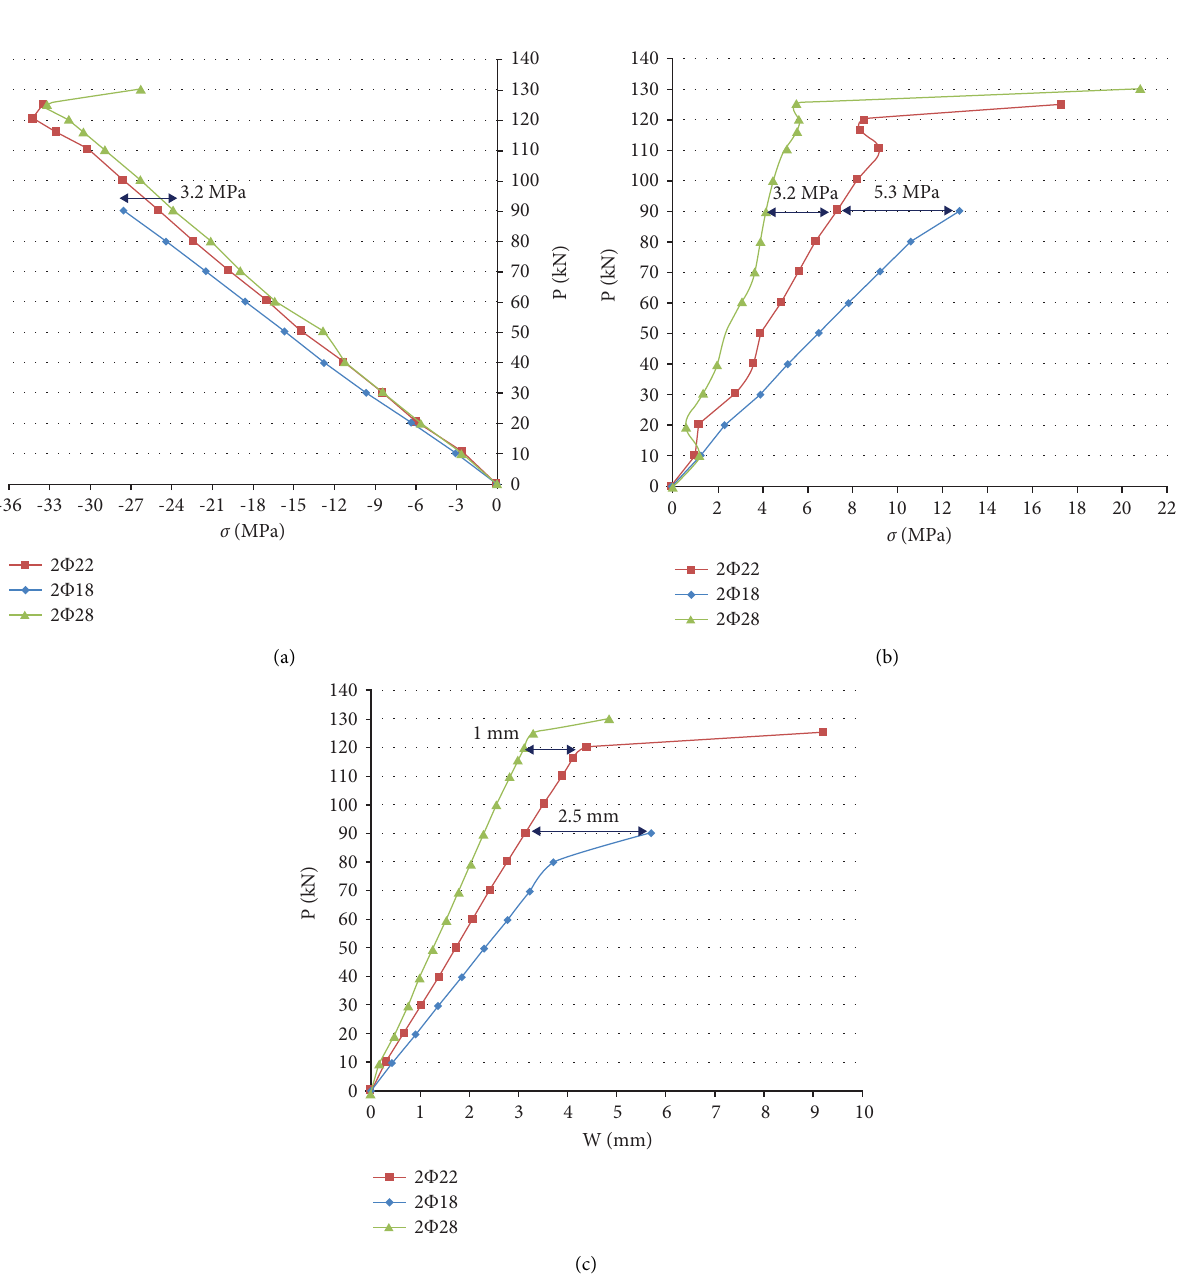
Figure 20: Relationship between load and stress, as well as between load and vertical displacement (efect of the diameter of tensile steel bars): (a) relationship between load and compressive stress, (b) relationship between load and tensile stress. (c) the relationship between load and